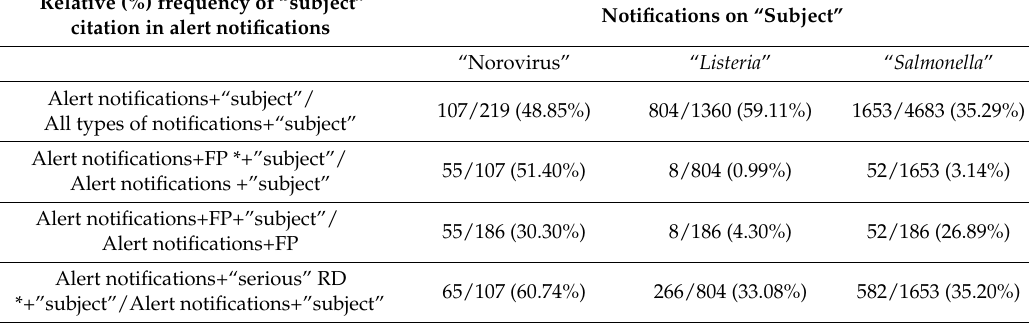
Table 4. Relative (%) frequency of citation of various “subject” notifications in alert notifications in “food” within the “pathogenic microorganisms” hazard category in the EU RASFF database (until 31 August